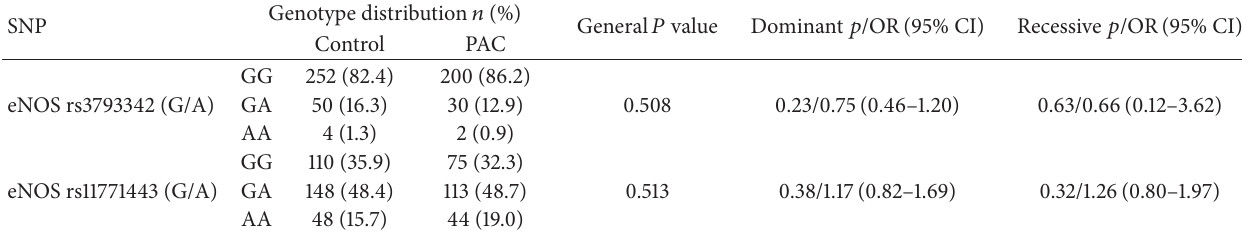
Table 4: Genotype frequency of SNPs in control and PAC subjects.